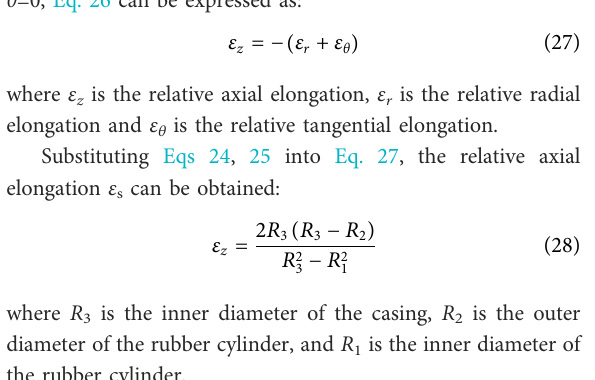
FIGURE 7 Schematic diagram of the rubber barrel structure.